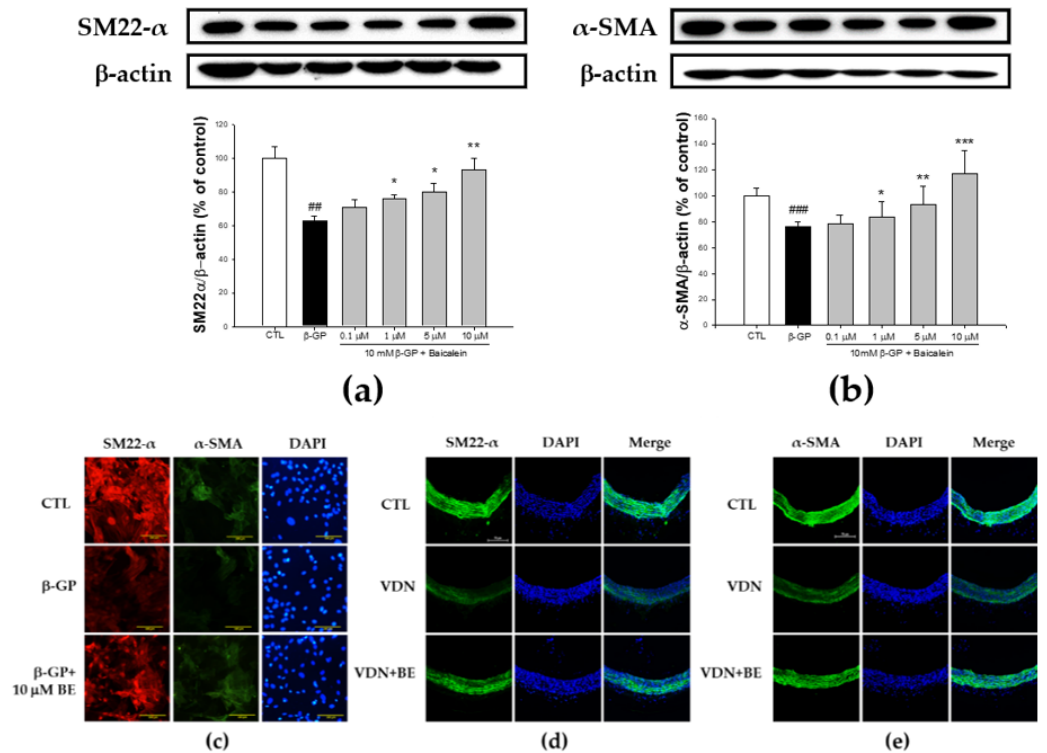
Figure 5. Baicalein enhances the expression of contractile-related proteins SM22- α and α -SMA in rat VC. Western blots for ( a ) SM22- α protein and ( b ) α -SMA protein. ( c ) The represent images of VSMCs were pretreated with 10 μM baicalein for 1 h before addition of 10 m M β -GP-induced calcification for 48 h. examined by double immunofluorescent staining. Bar shows 100 μm. The immunofluorescence detection of ( d ) SM22- α and ( e ) α -SMA proteins using confocal microscope (200x) in SD rat aorta tissue. Counterstaining of nuclei with DAPI in blue was merged into all images. Bar shows 50 μm. All values are presented as mean ± SEM. ## p < 0.005; ### p < 0.001 vs. control group (untreated VSMCs); * p < 0.05; ** p < 0.01; *** p < 0.001 vs. the β -GP group.